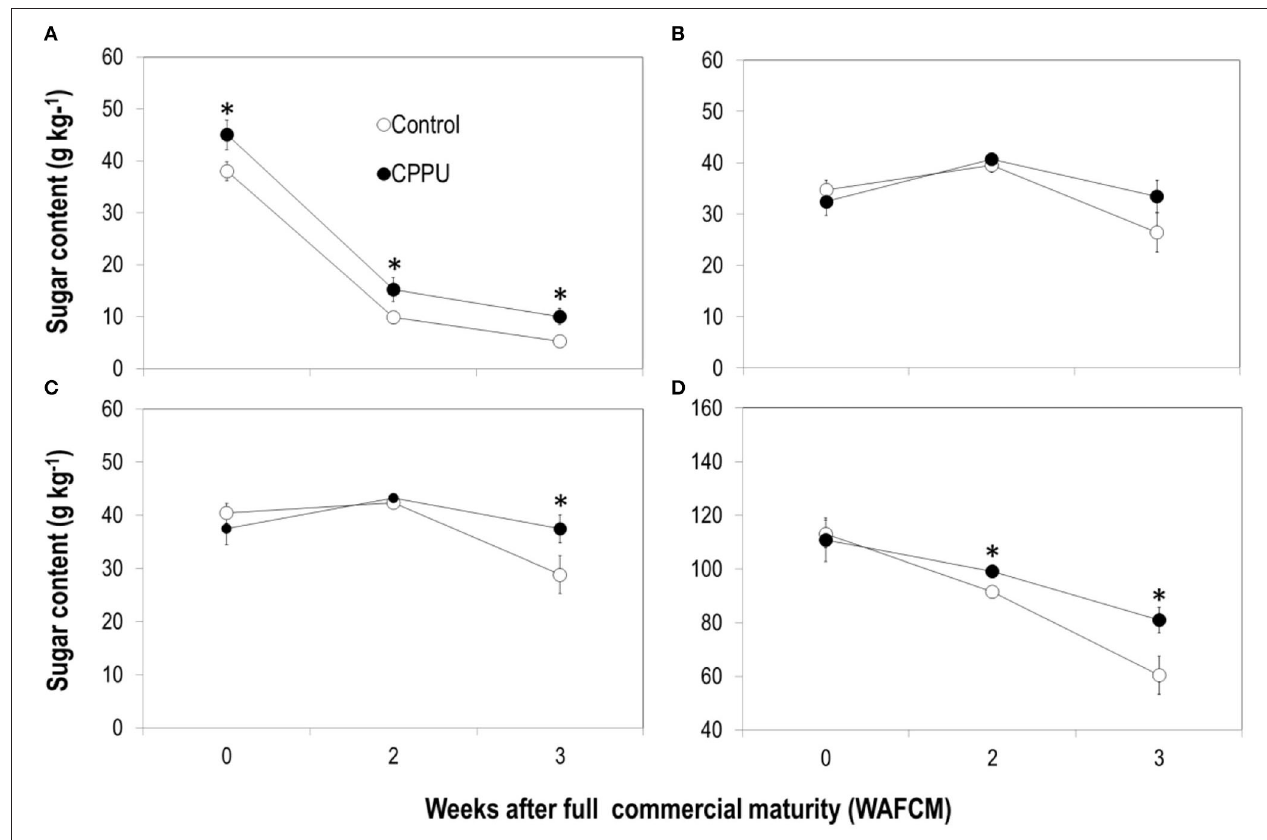
FIGURE 6 | Effect of preharvest application of CPPU on changes in sucrose (A) , glucose (B) , fructose (C) , and total sugars (D) in the aril of the ripe “Feizixiao” litchi fruit remained on tree. Vertical bar at each data point stands for standard error ( n = 5). *Indicates significant difference between CPPU treatment and the control at p < 0.05, Student’s t -test.